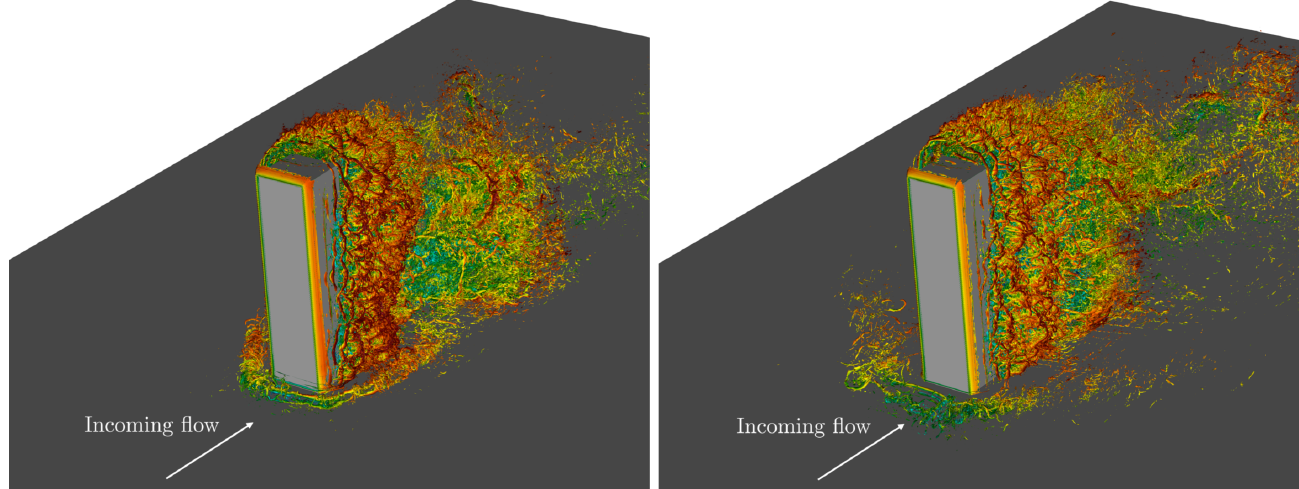
Figure 6. Instantaneous flow visualizations showing vortical structures [22] around a wall-mounted square cylinder, with ( left ) turbulent- and ( right ) laminar-inflow conditions. We show λ 2 isosurfaces of − 40 (based on U ∞ and w b ), and the structures are colored by streamwise velocity, ranging from (dark blue) − 1.2 to (dark red) 1.8. Figures produced from the databse by Vinuesa et al.